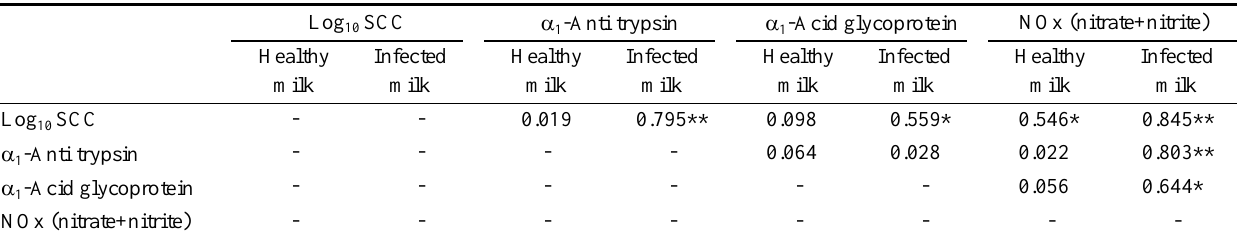
Table 6. Correlation coefficient of milk biochemical components in healthy and SCM milk of riverine buffalo (n = 496)